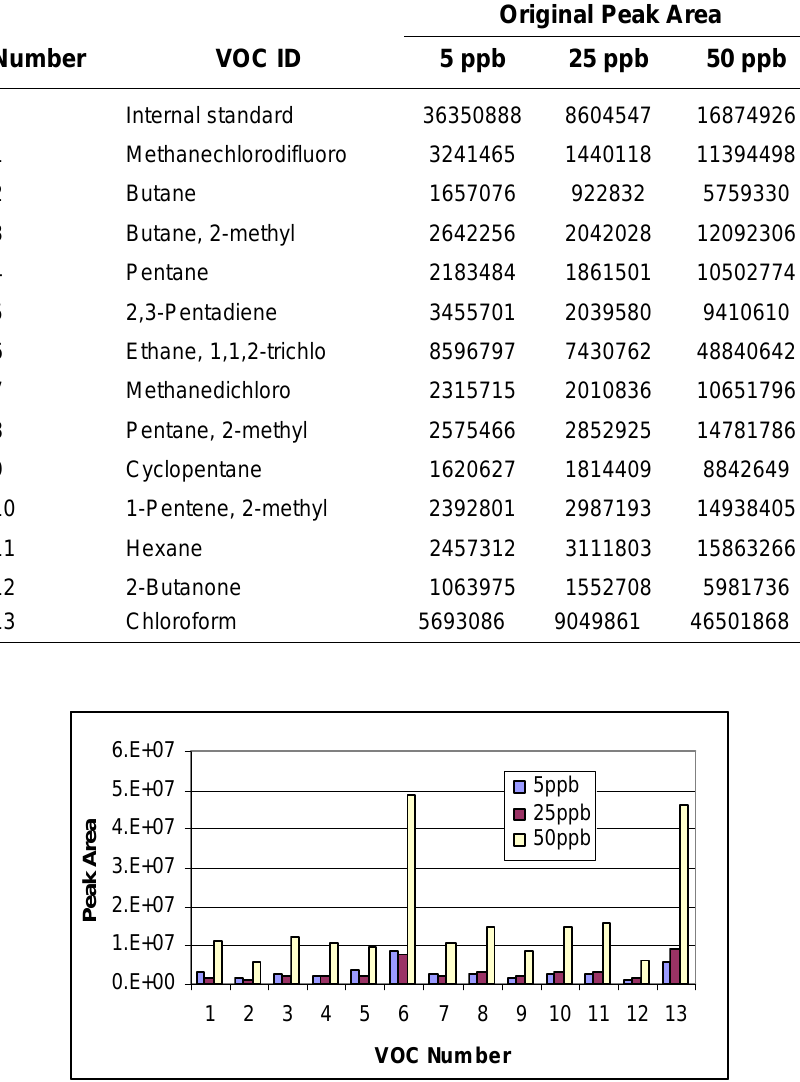
Comparison of VOCs and Internal Standard Peak Areas at Three Concentration Levels Original Peak Area